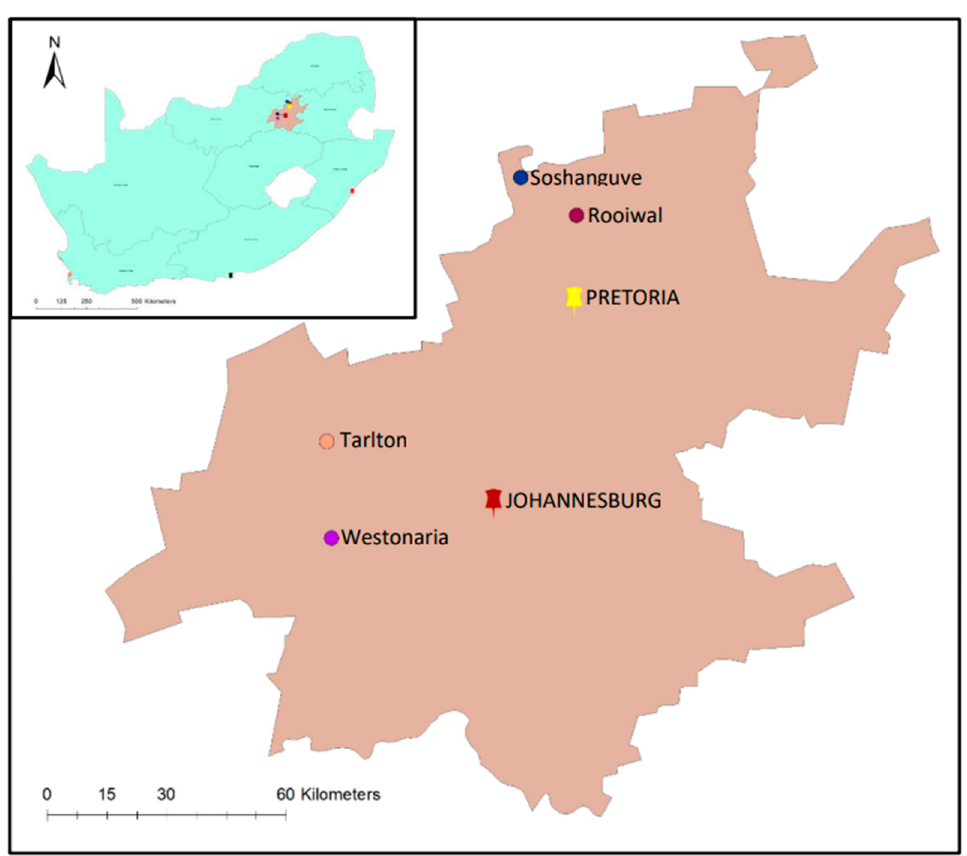
Figure 1. Map of Gauteng province showing locations of Soshanguve, Rooiwal, Tarlton, and Westonaria relative to the cities of Pretoria and Johannesburg. Insert is a map of South Africa showing the location of Gateng Province.